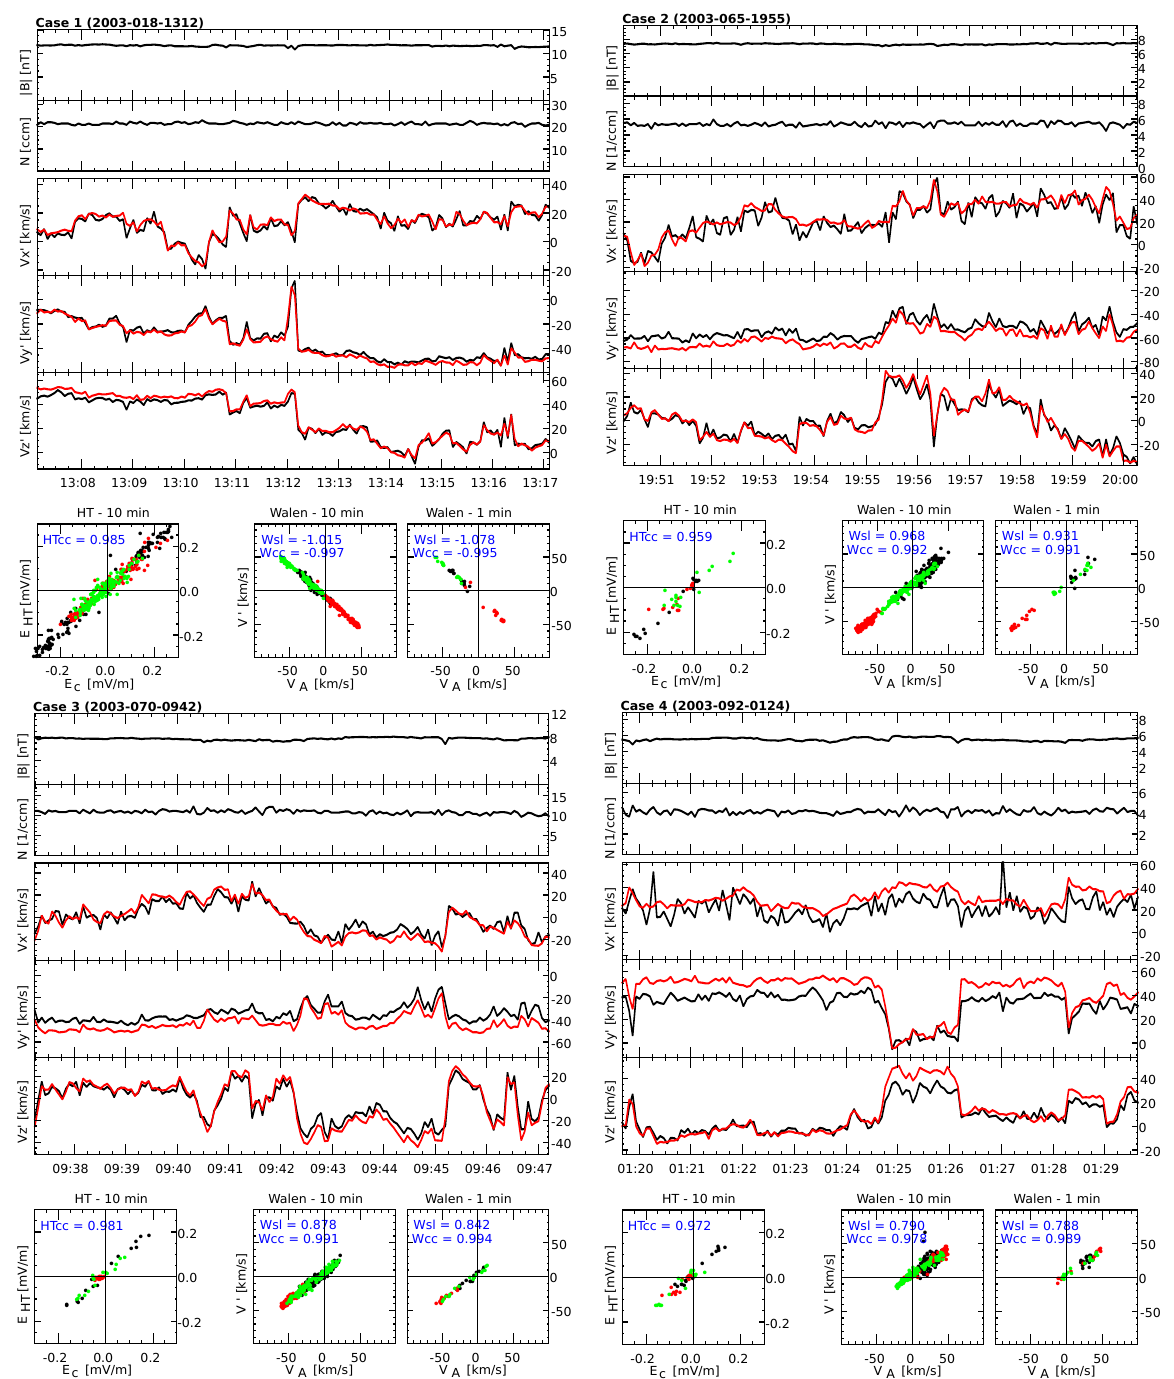
Fig. 2. Overview plots for DD crossings 1 through 4 from Table 1. For each case, the five panels at the top show the magnetic field magnitude, the plasma density, followed by a comparison between the three components of v 0 = ( v − V HT ) (in black) and (in red) the three components of - V A or V A (depending on the sign of the Wal´en slope), all from Cluster C1, with the DD at the center of the time series. The panels along the bottom show the HT scatterplot for the 10min interval, and the Wal´en scatterplots for the full 10min and for the 1min interval centered on the DD. In these scatterplots the vector components are distinguished by their color (black for x , red for y , and green for z ). For details on the HT scatterplot, see Appendix